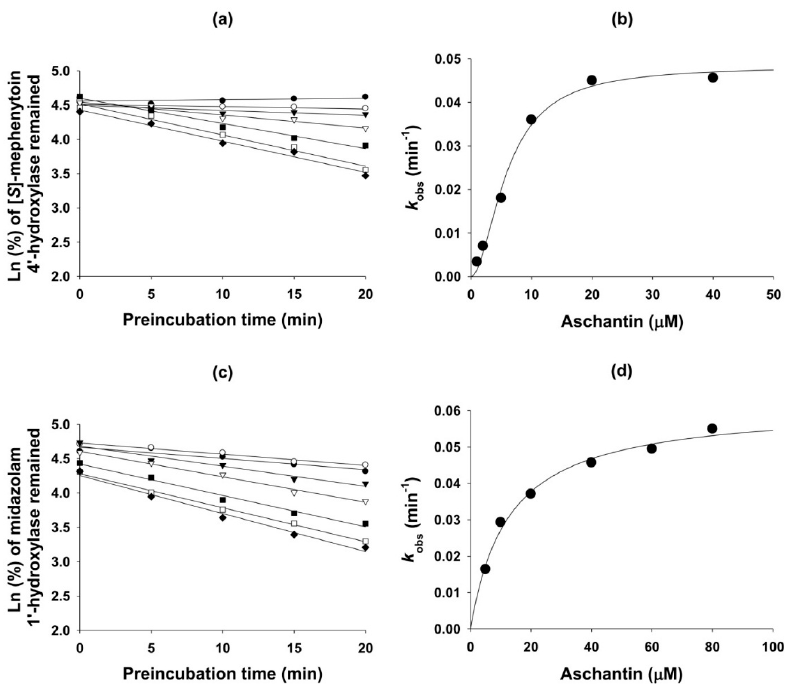
Figure 4. ( a ) The kinetics of inactivation of microsomal formation of 4’-hydroxy-[ S ]-mephenytoin